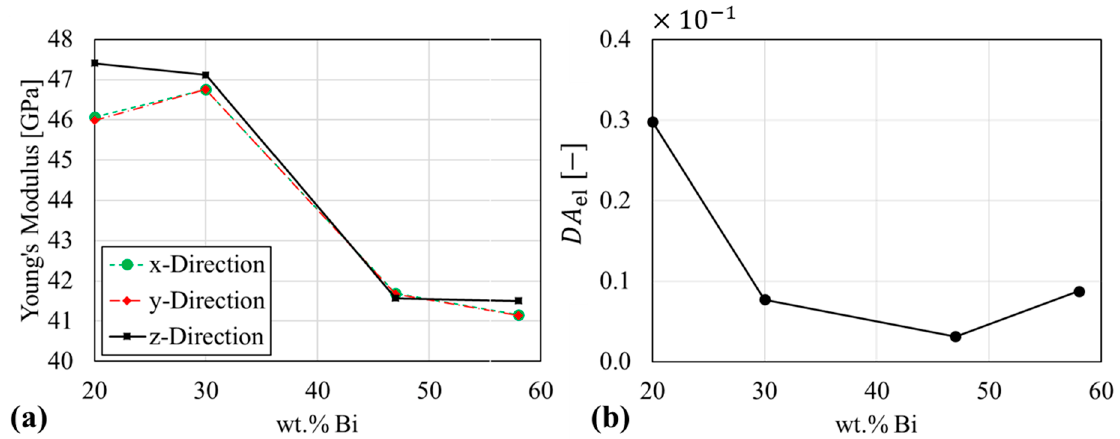
Figure 16. Evaluation of calculated elastic anisotropy from RVE-FEM models ( a ) Young’s moduli from unidirectional tensile deformation ( b ) degree of anisotropy from Young’s modulus.